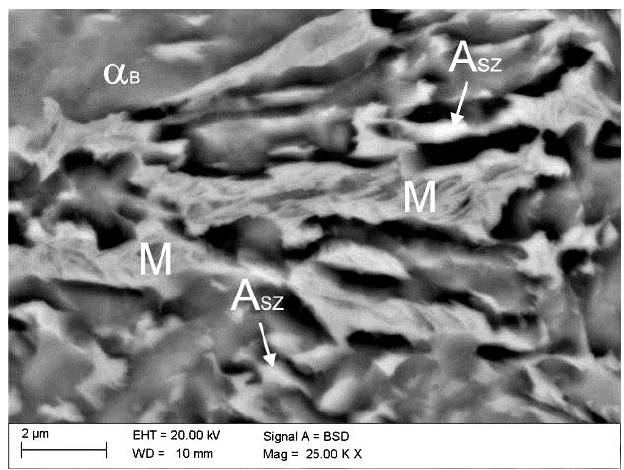
Figure 8. Microstructure of 3Mn-1.5Al steel after tensile test; α B — bainitic ferrite, M — martensite, A SZ — retained austenite.